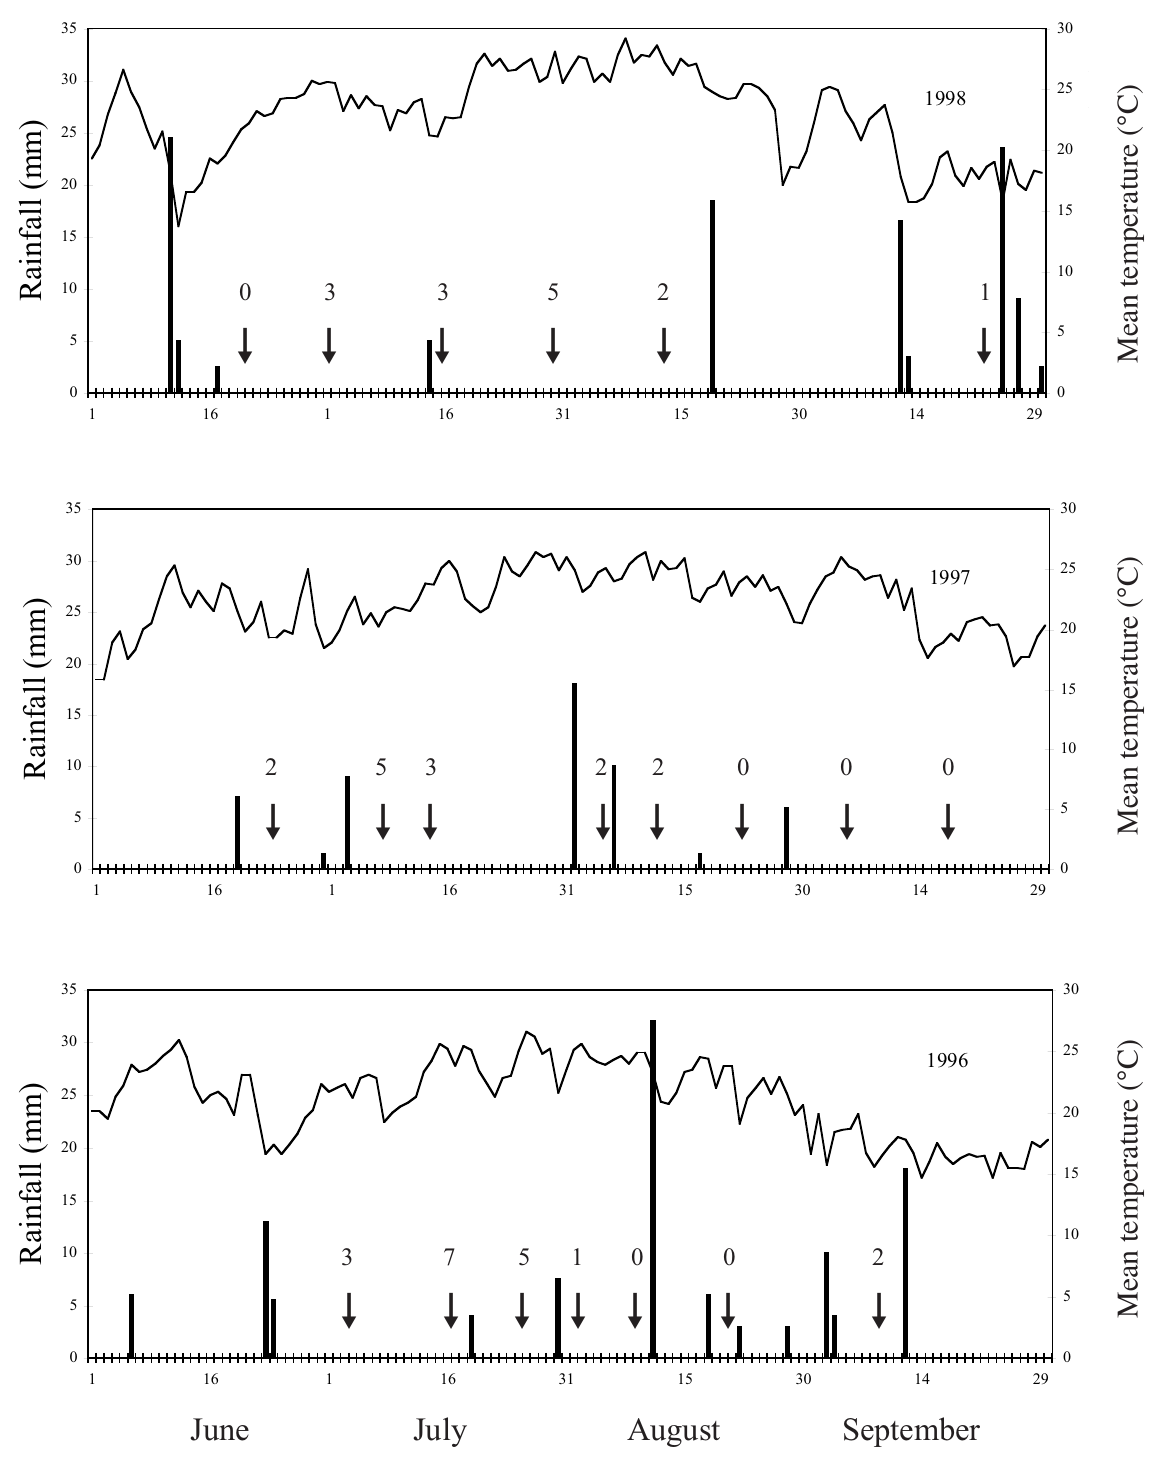
Fig. 7. Apopletic strokes (arrow), mean daily temperature (continuous line) and rainfall (bar) from June to Septem- ber 1996-1998 in a vineyard at Gambassi Terme